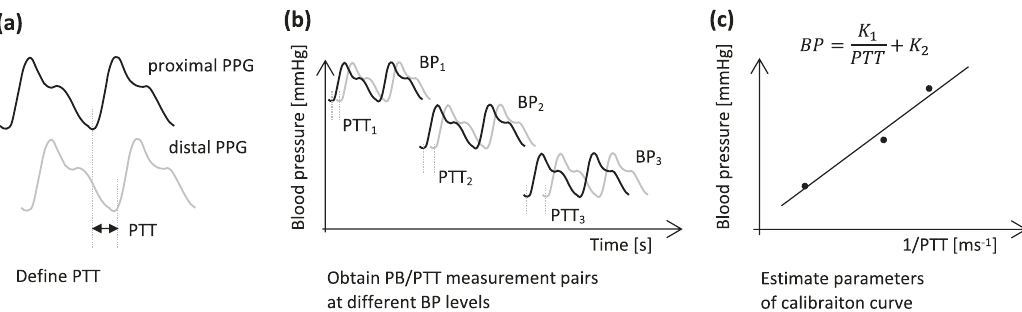
Fig. 6 Work fl ow of PTT-based BP estimation. PTT stands for pulse transit time, PCG for Phonocardiogram, and BP for blood pressure. First, PTT needs to be de fi ned based on the available signals, where different combinations can be used ( a ). Then, multiple measurement pairs of PTT and BP need to be obtained ( b ). With these measurements, the unknown parameters of the calibration curve can be estimated ( c